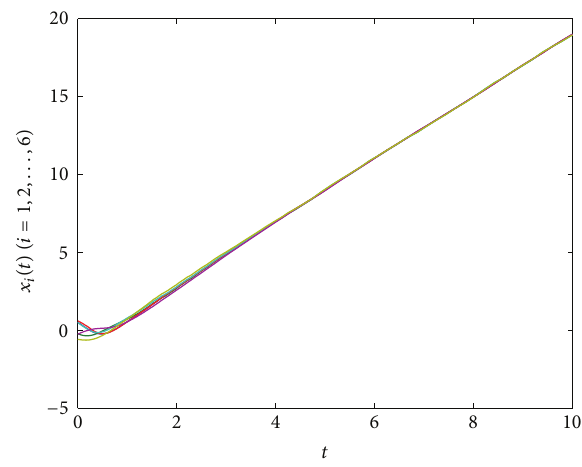
Figure 4: The position curves 𝑥 𝑖 (𝑡) (𝑖 = 1,2, . .. ,6) for nonlinear multiagent systems (43) with 𝜏 0 = 0 , 𝜏 1 = 0.2 , 𝜏 2 = 0.3 , 𝛽 1 = 0.1 , and 𝛽 2 = 0.9 .